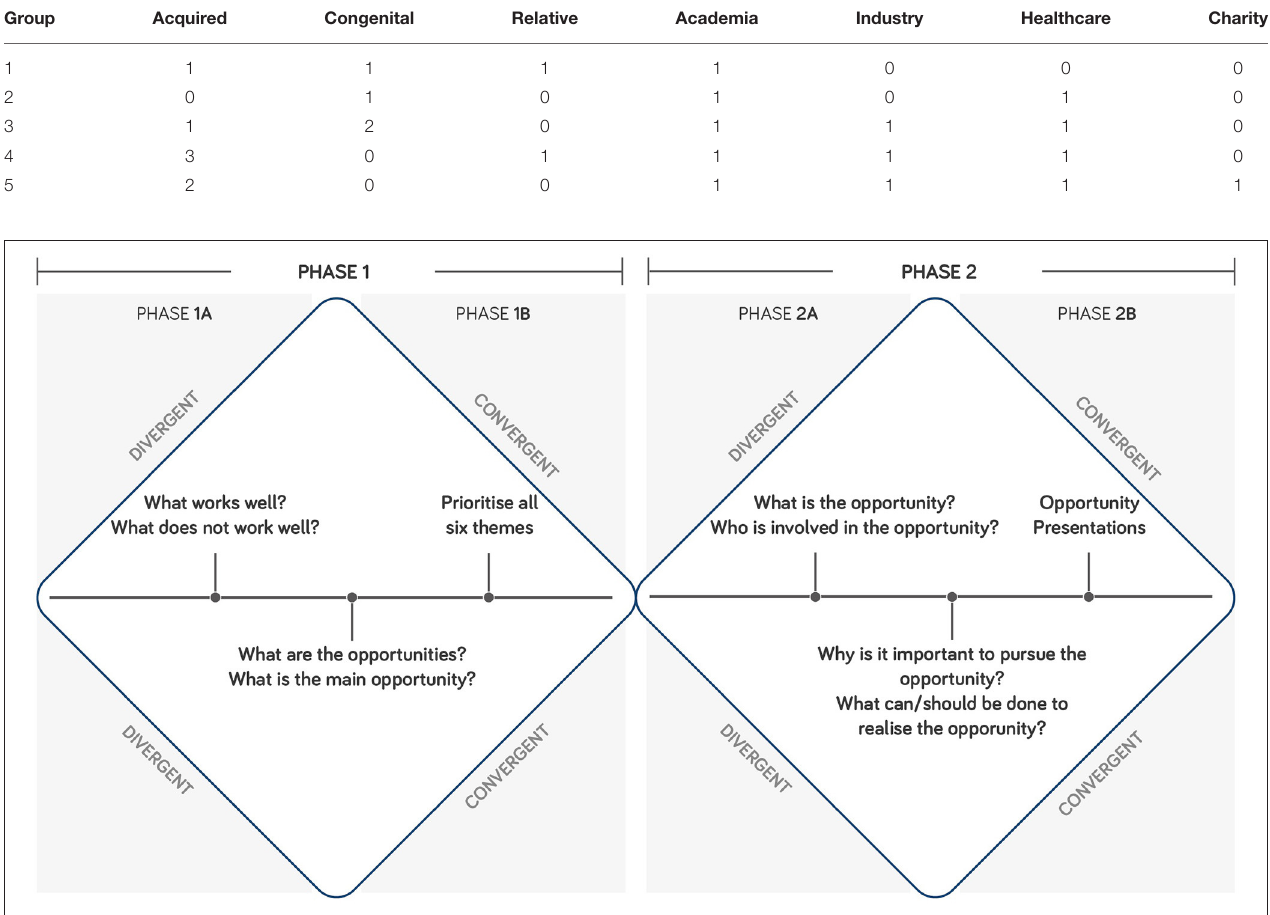
TABLE 2 | Co-creation workshop groups.